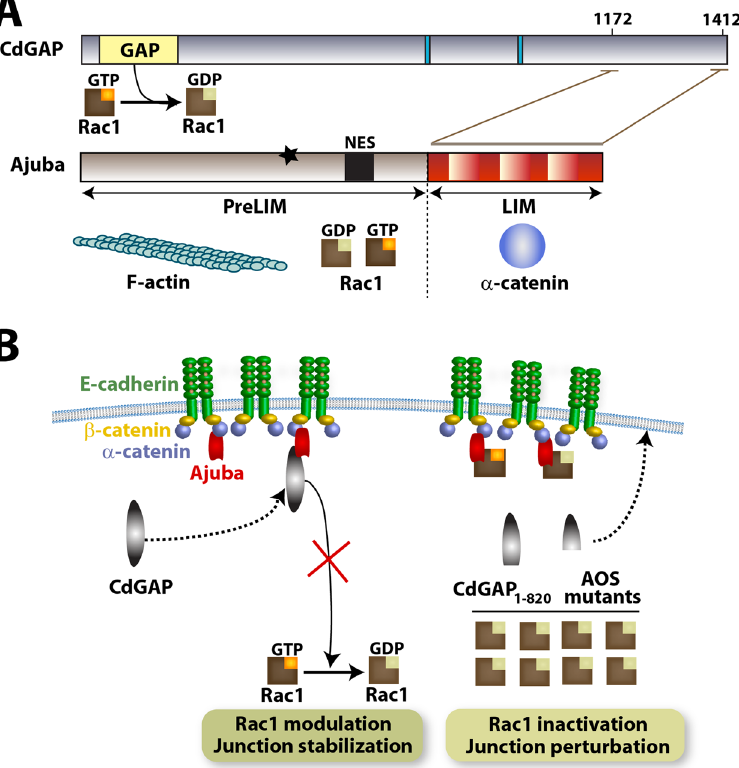
Figure 7. Summary of results. ( A ) Diagrams showing CdGAP and Ajuba domains, their respective partners and functional interaction with Rac1. CdGAP C-terminal residues R1172 and R1412 interact directly with Ajuba LIM domains. Ajuba LIM domains also associate with α -catenin, while PreLIM domains bind to F-actin. The preLIM domain also interacts equally with active or inactive Rac1, unless it is phosphorylated by PAK1 (black star) which increases its affinity for activated Rac1. (B ) CdGAP is recruited to junctions via an unknown mechanism. CdGAP is maintained at cell-cell contacts via binding to Ajuba, which keeps CdGAP in an inhibited status, thereby preventing Rac1 inactivation locally. CdGAP 1–820 and the AOS mutants lack the C-terminal region that interacts with Ajuba, have higher catalytic activity and stronger ability to perturb